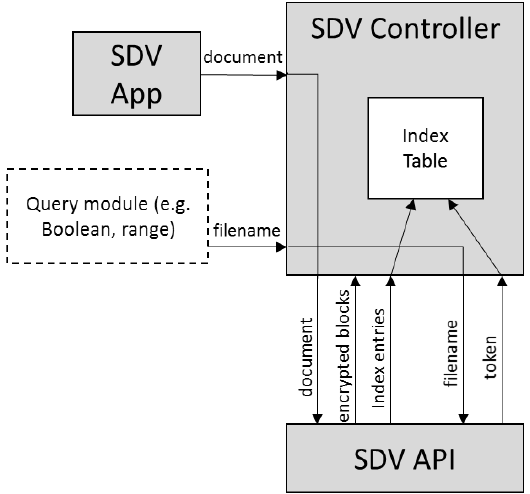
Figure 2. SDV controller—indexing and search: The SDV app submits a document to the SDV controller, which forwards the document to the SDV API. The SDV API then executes the underlying SSE scheme. The document is divided into blocks. The encrypted blocks, together with an index entry of the document are returned to the SDV controller, which then inserts the index entry to a query index table, and forwards the encrypted blocks to their respective servers based on the index entry. The index entry contains a token generated based on filename, and also information on where to store/retrieve the encrypted blocks of the document with the filename. The search then is simple: submit a filename to the SDV controller and a token is generated by the SDV API to search the index table. Given such a setting, a query module for more expressive search (e.g., Boolean) can be added as an additional module, as long as the search result for this module is a list of